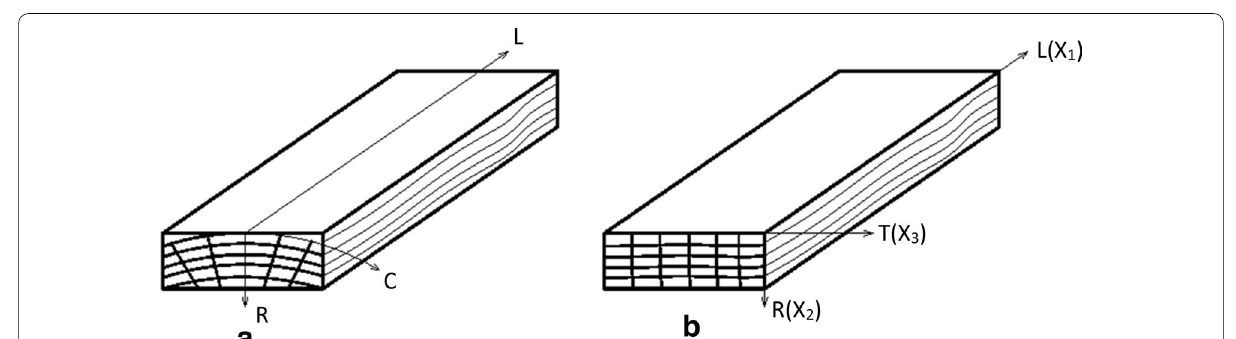
Fig. 11 Orthotropic property of wood [27]: a three-dimensional orientation of wood; b orthogonal Cartesian axes